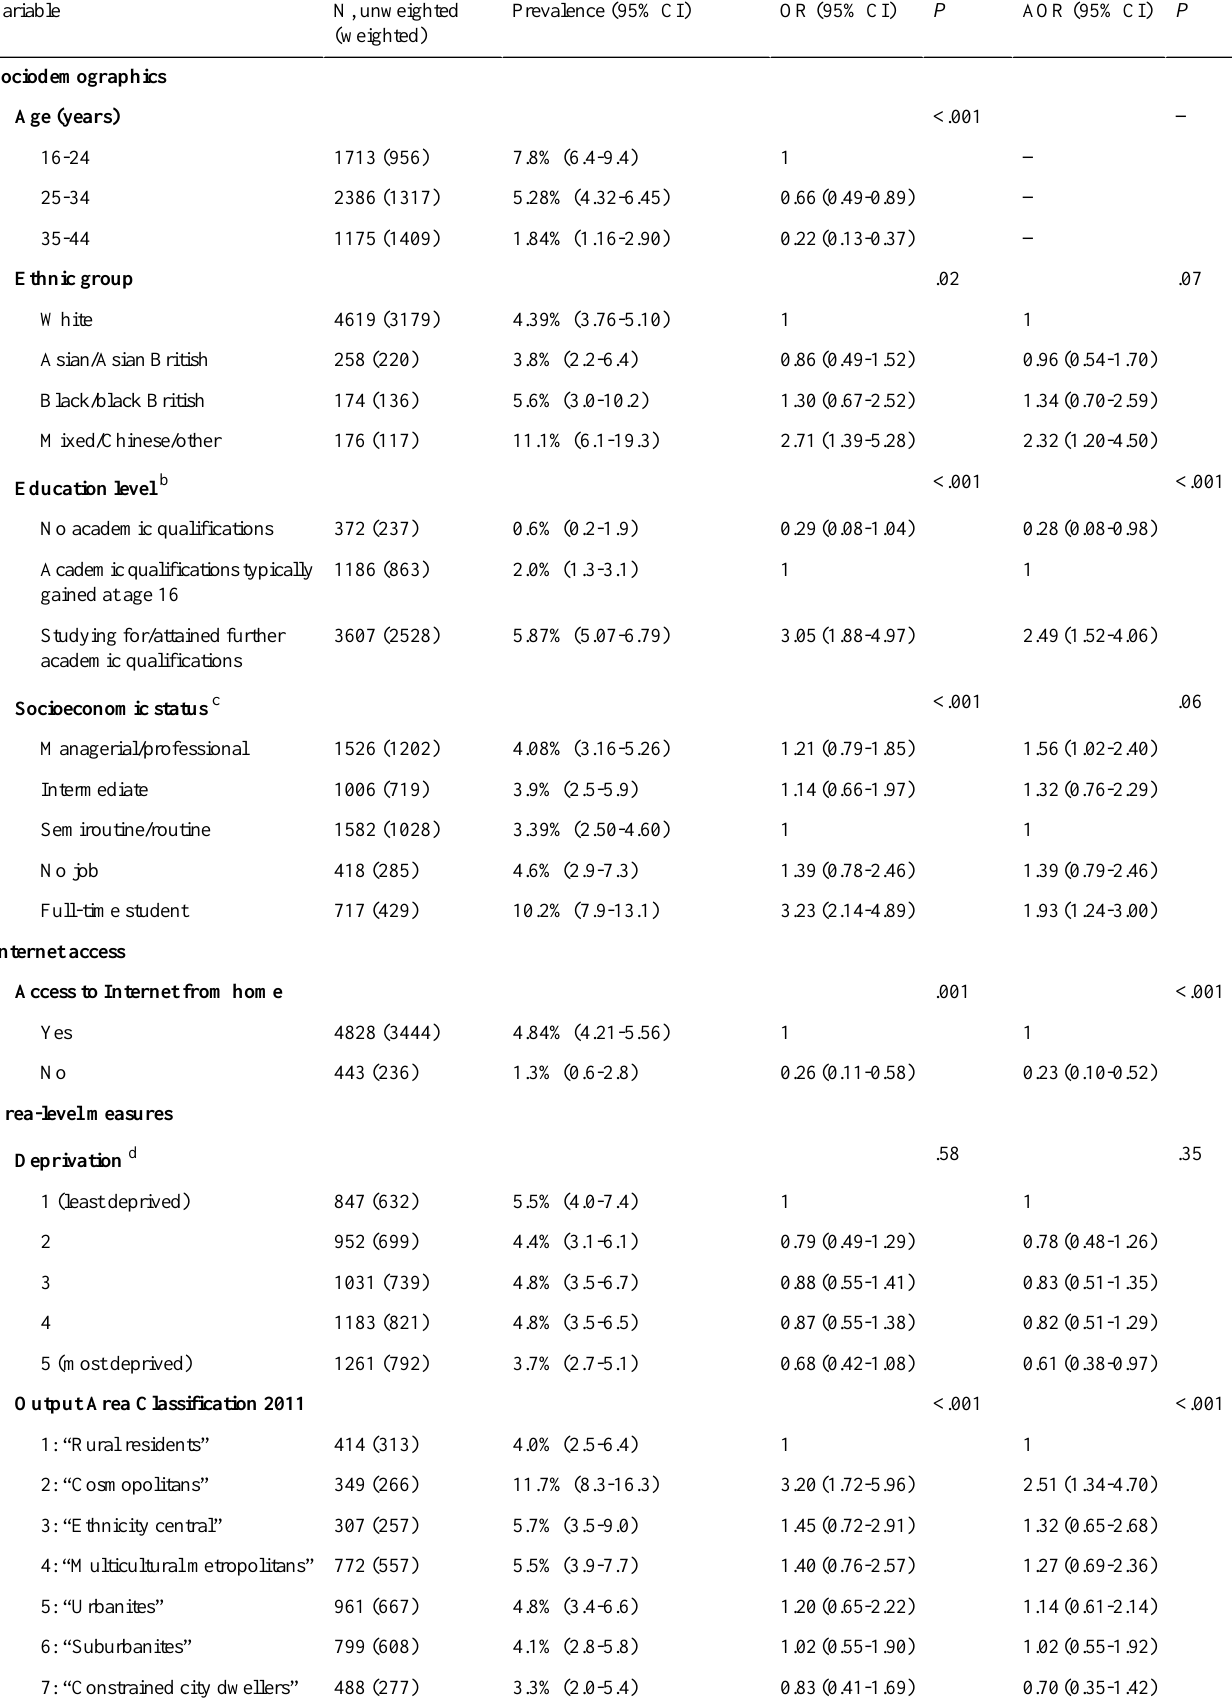
Table 4. Variation in the prevalence and odds of reporting recent (past year) use of Internet information/support among sexually experienced women aged 16 to 44 years.